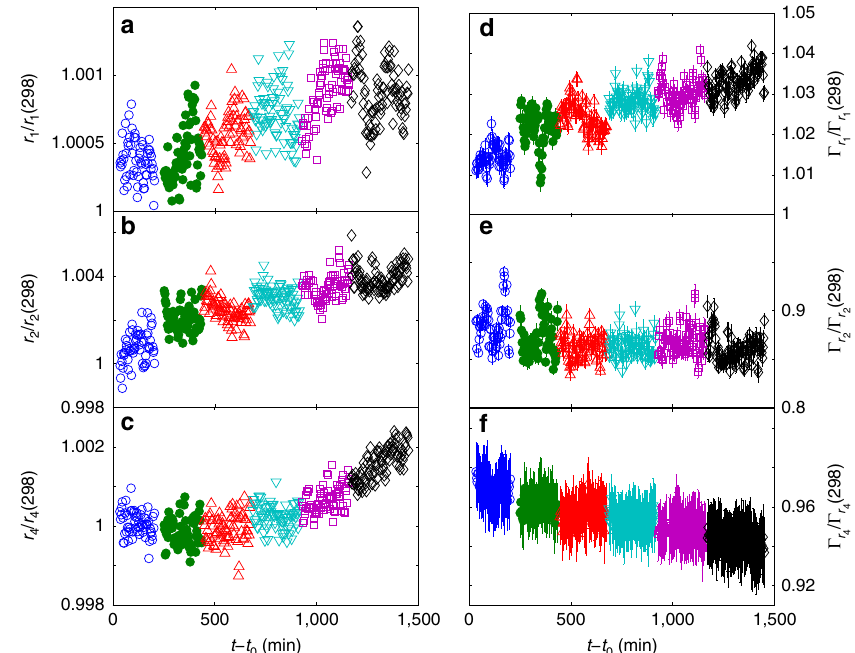
Figure 5 | Atomic rearrangements behind the secondary fast relaxation process. Relative change of position ( a – c ) and width ( d – f ) of the first three shells of G ( r ) as a function of time during the different isotherms. r 1 , r 2 and r 4 correspond to the positions reported in Fig. 3. Symbols are as in Fig. 1. Error bars for positions are within the symbol